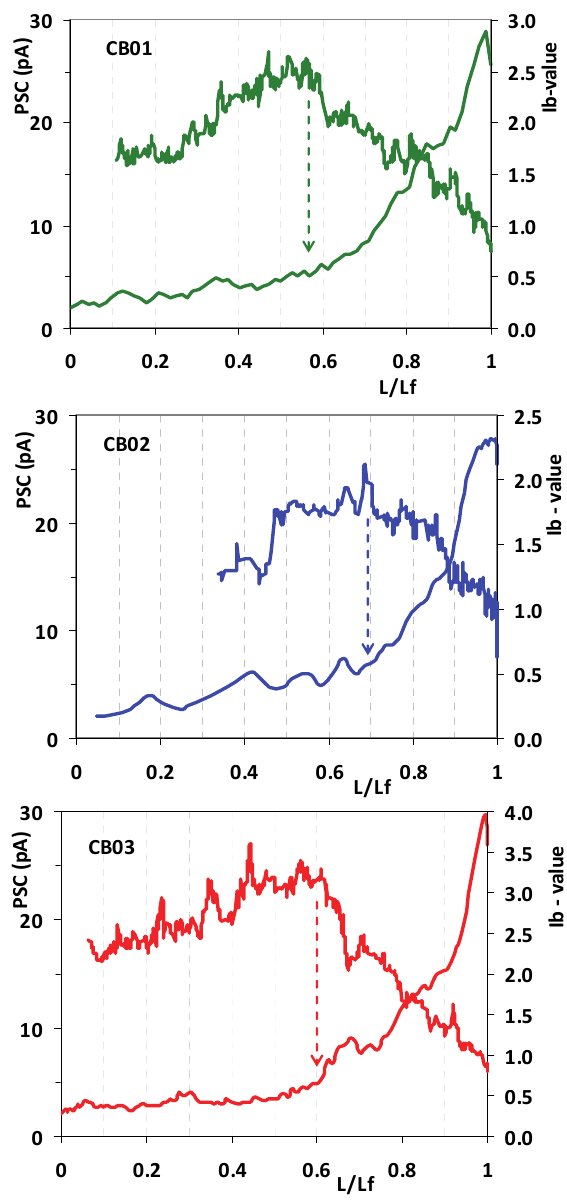
Figure 4: Variation of b I -values and PSC signals vs. normalized load (L/L f ) for the three conducted